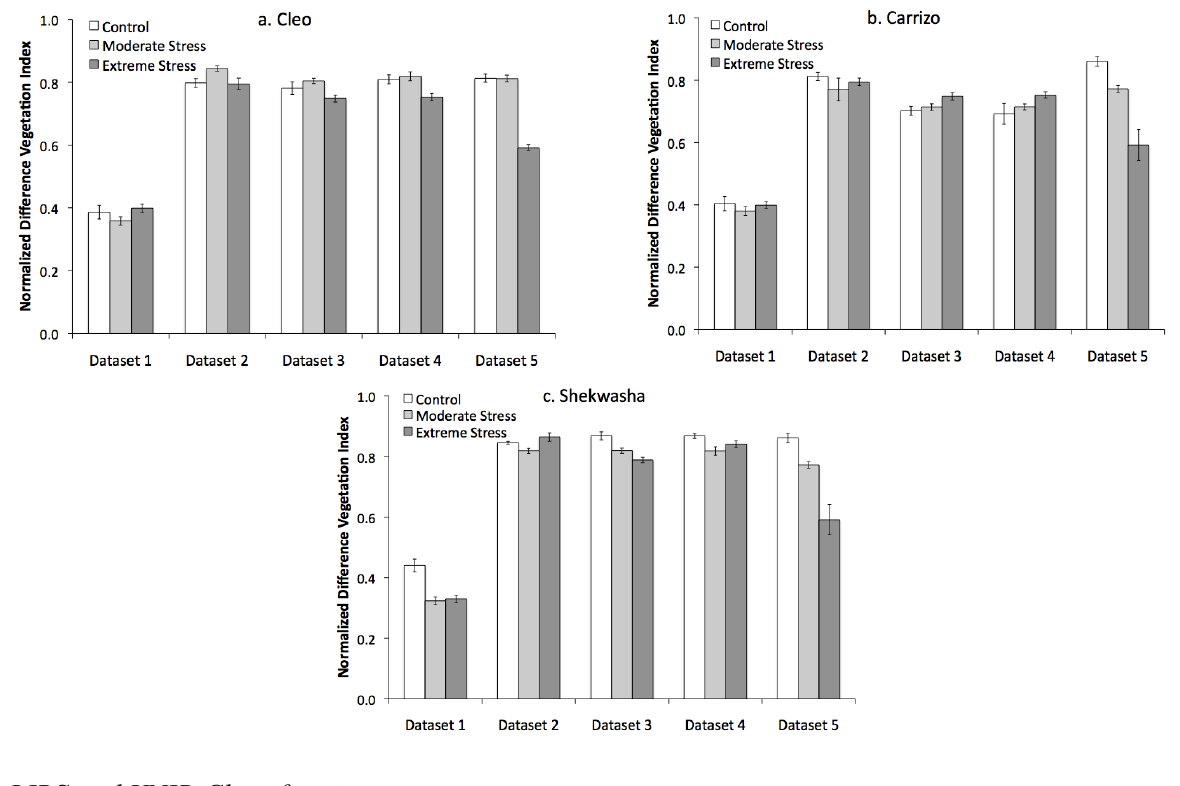
Figure 5. Normalized Difference Vegetation Index (NDVI) values of ( a ) Cleo; ( b ) Carrizo; and ( c ) Shekwasha seedlings.